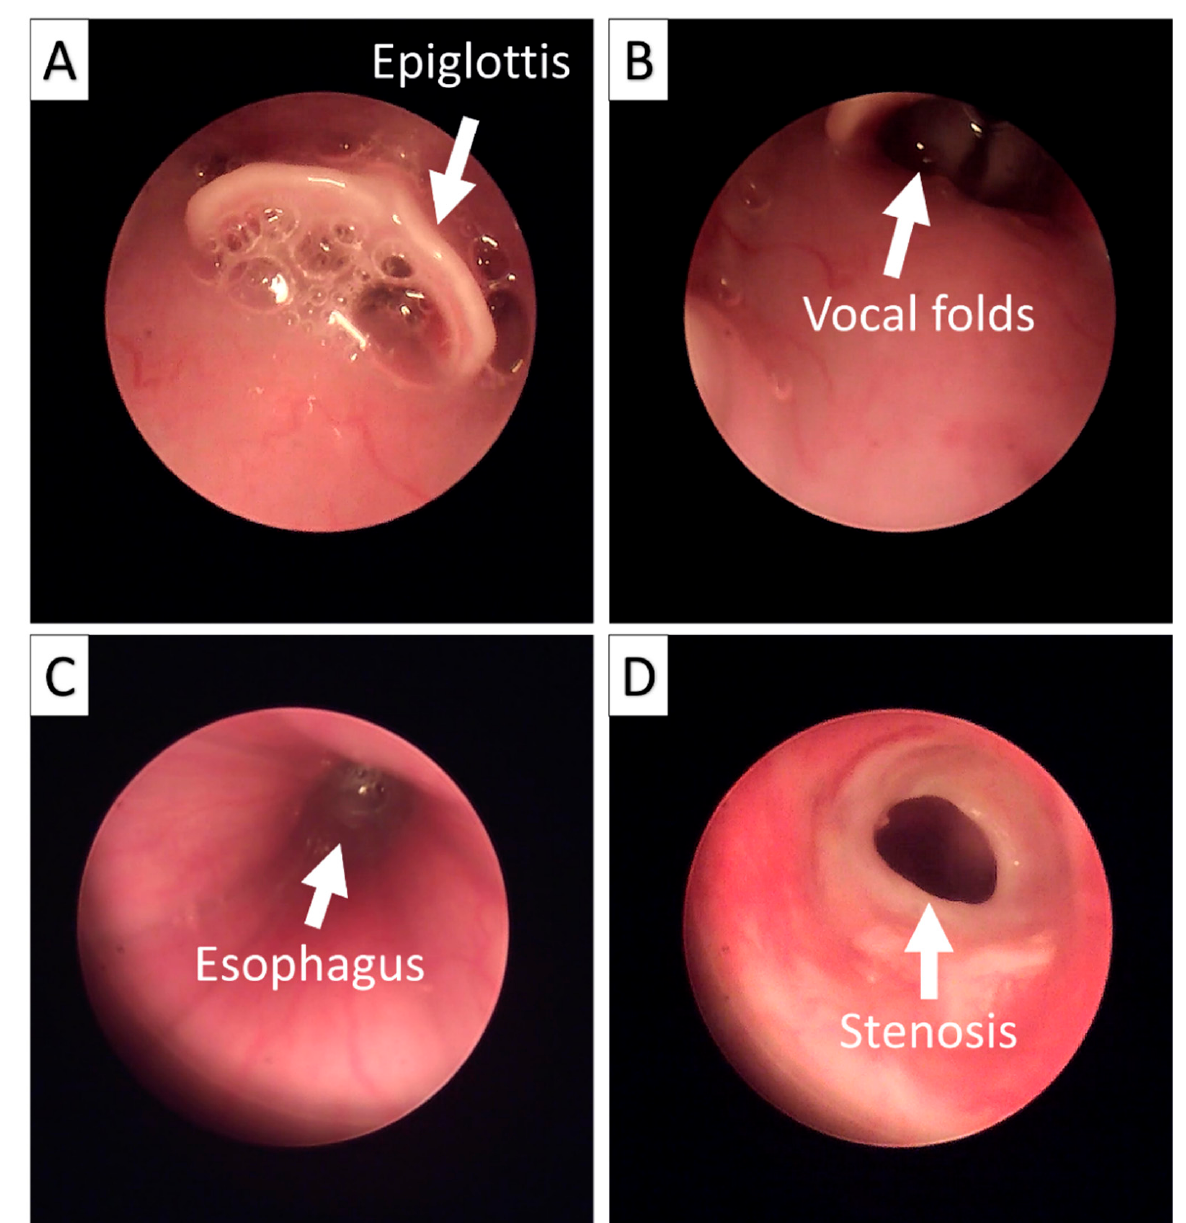
Figure 6. Endoscopic examination of the tracheal allograft segment in rabbits 2 months after orthotopic transplantation. ( A ): Epiglottis; ( B ): Vocal folds; ( C ): Esophagus; ( D ): Circular stenosis ring at the anastomosis site.